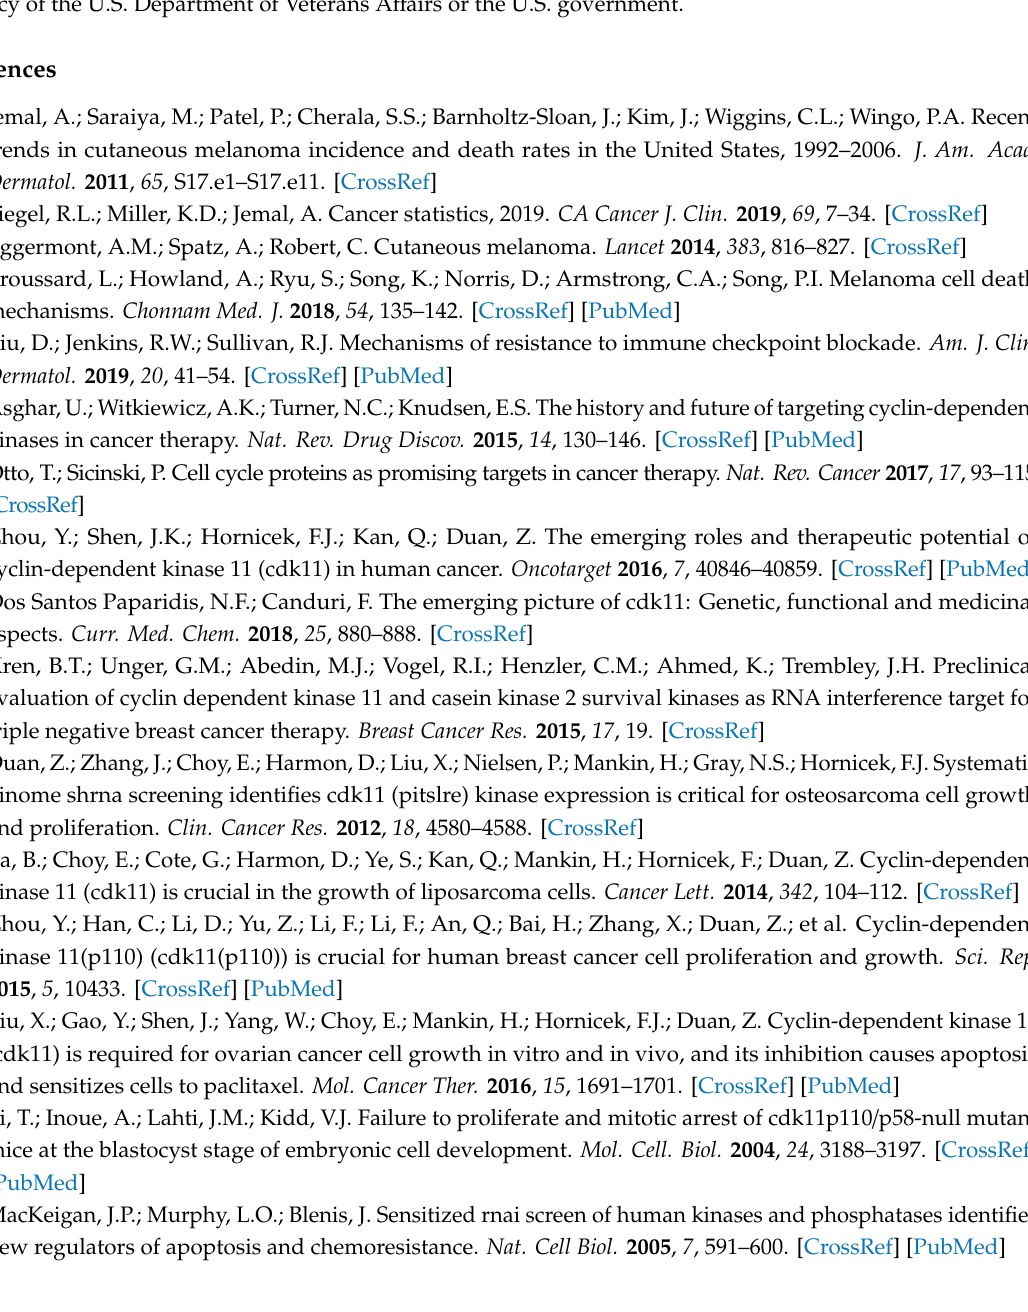
Table S1: Significantly di ff erentially expressed genes identified in A375 cells using the PanCancer Pathways panel (NanoString Technologies). Table S2: Data from 102 patients included in survival analysis from The Protein